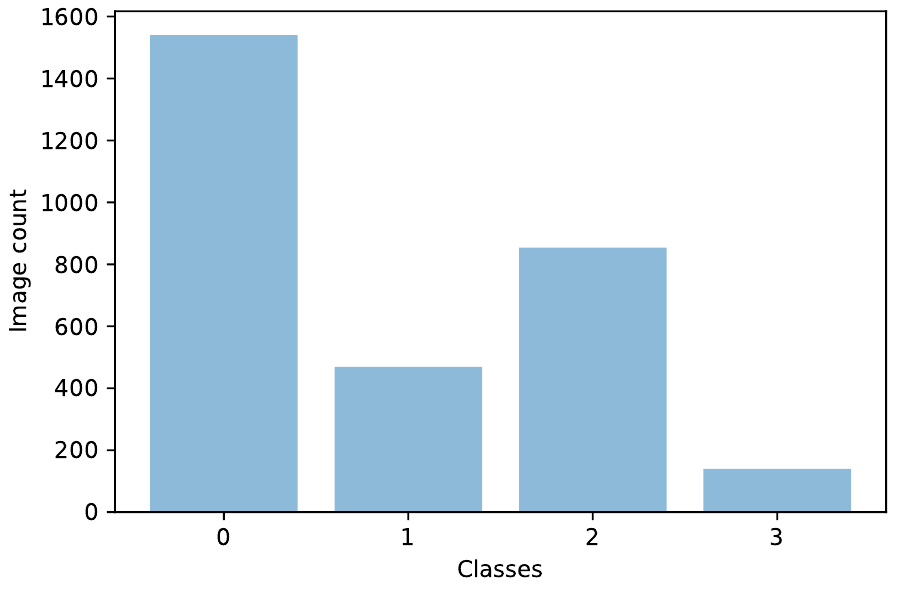
Figure 3. The training data contain 51.28%, 15.61%, 28.43%, and 4.66% samples of each class, corresponding to 1540, 469, 854, and 140